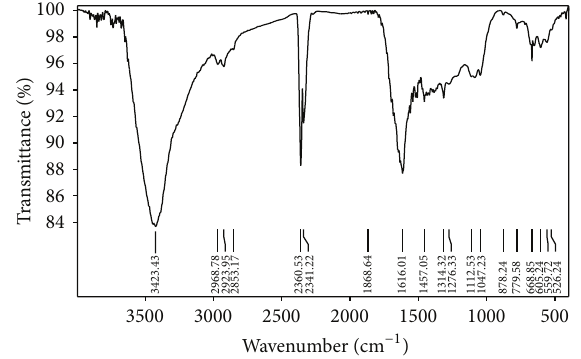
Figure 3: FT-IR spectrum of carbon